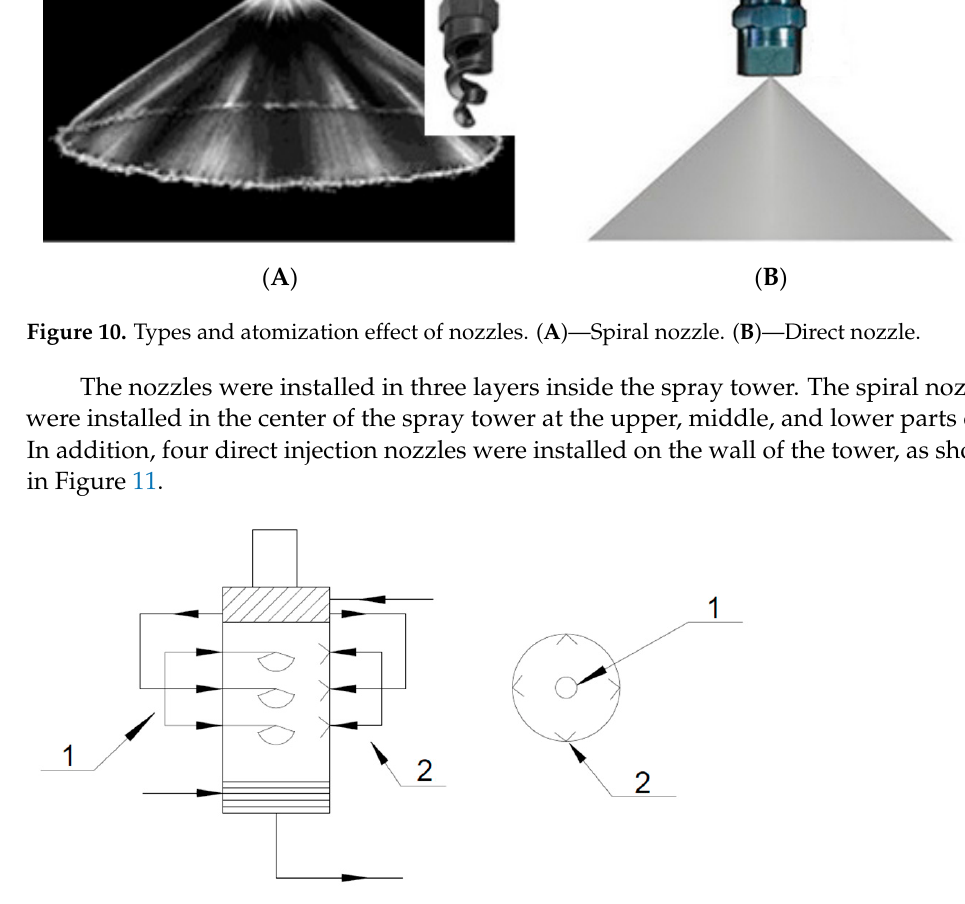
Figure 11. Nozzle installation layout. 1—Spiral nozzle system. 2—Direct injection nozzle. Additionally, a 2 mol/L NaOH solution concentration was selected for the experiment with the direct nozzle while the other conditions remained unchanged. Table 11 presents the results. Table 11. Effect of exhaust gas velocity on CO 2 absorption rate (direct nozzle).